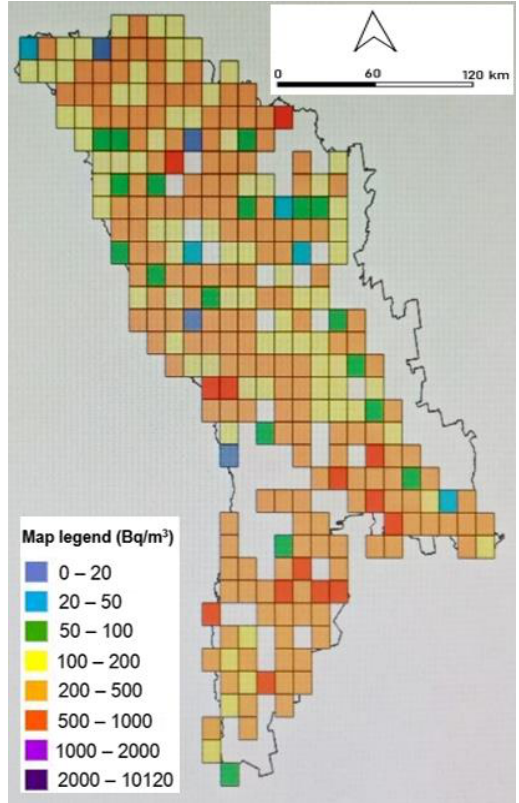
Figure 5. Mapping radon in the air of various types of housing, in rural and urban areas, in the Northern, Central and Southern areas of the Republic of Moldova. The radon concentration ranges specified in the map legend are in accordance with the European radon map, Joint Research Commission [14].